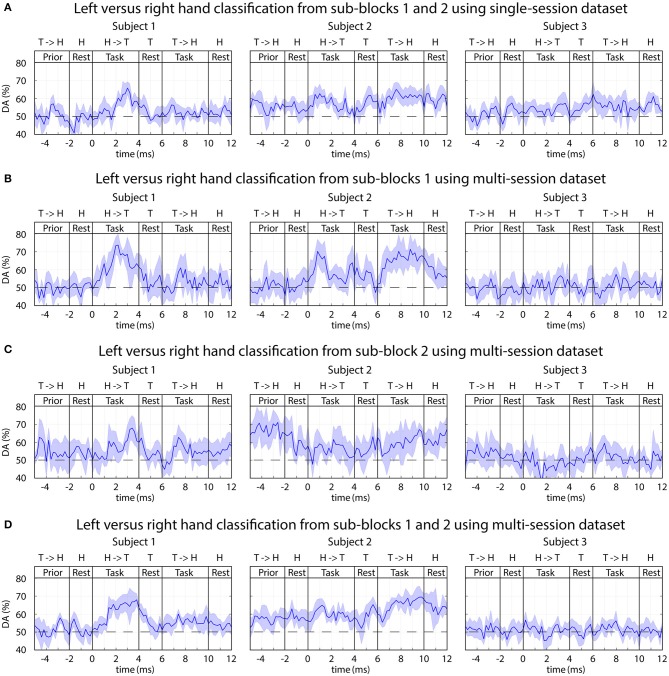
FBCSP: time-varying DA of Left vs. right imagined hand movements. (A) Results of the single-session analysis. (B–D) Results from the multi-session analysis where (B) trials from sub-block1 (visual and auditory cue), (C) trials from sub-block2 (auditory cue without displayed movement), (D) trials from both sub-blocks pooled together. The horizontal dashed line indicates the chance level (50% for 2-class classification).